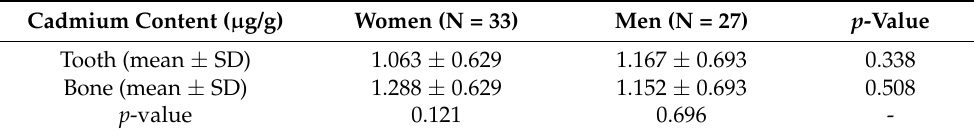
Table 4. Cadmium content in tested samples taken from patients of different sexes.